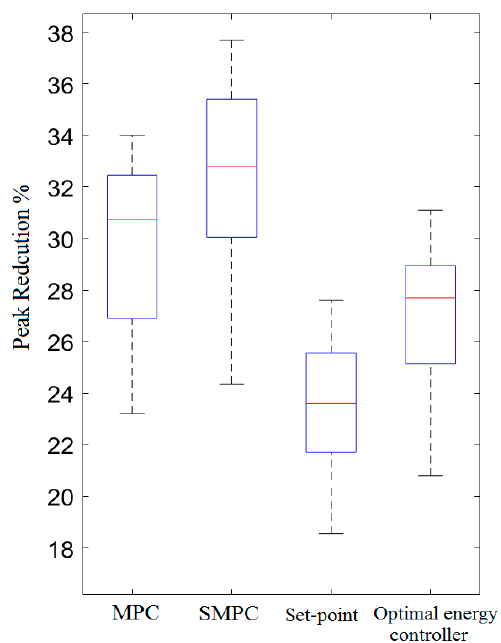
Figure 8. The distribution of the daily peak demand reduction as box plot achieved by predictive controllers, optimal energy controller with fixed load forecast and set-point